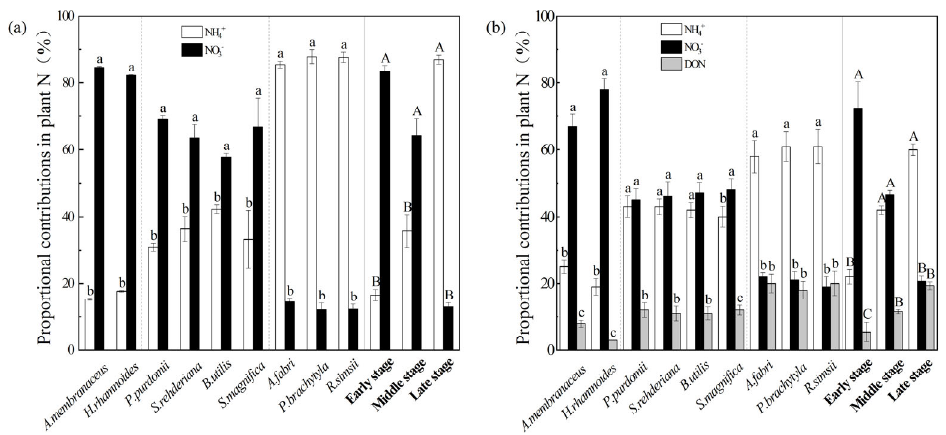
Figure 3. The proportional contributions (%) of soil NH 4+ and NO 3 − ( a ) in dominant plants N, and the proportional contributions (%) of soil NH 4+ and NO 3 − and DON ( b ) in dominant plants N at different successional stages. White, gray, and black bars represent the proportional contributions (%) of soil NH 4+ and NO 3 − and DON in the plant nutrition of dominant species, respectively. Different capital and lowercase letters denote significant differences among successional stages, and different species, respectively ( p < 0.05), according to Tukey’s test of one-way ANOVA.